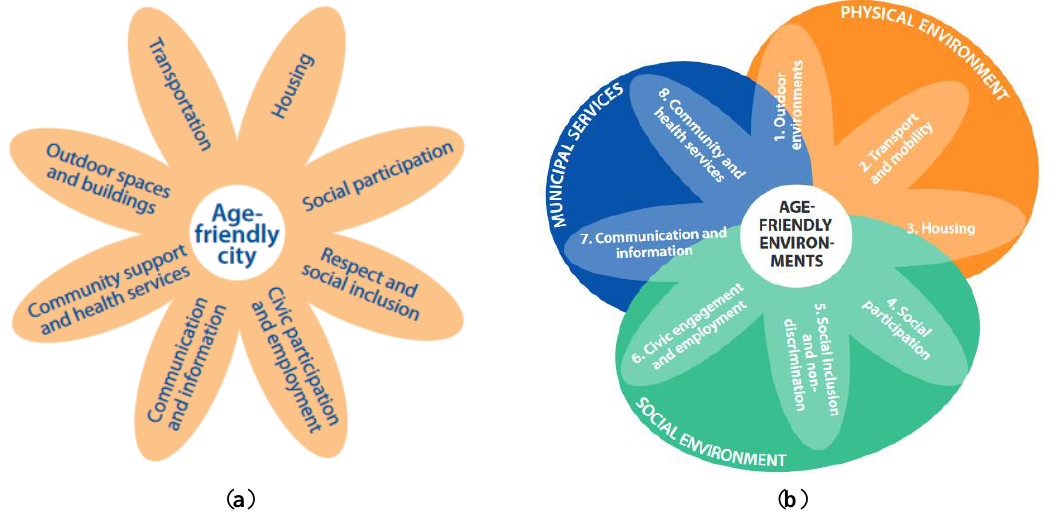
Figure 1. ( a ) Age-Friendly City (AFC) domains [10]. ( b ) Eight domains for age-friendly action [14].